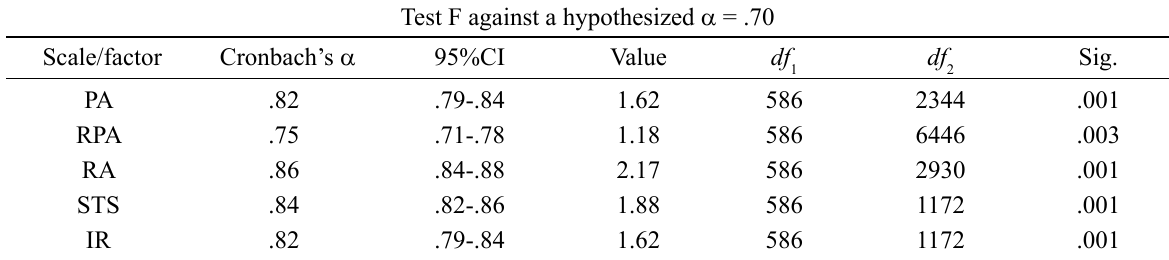
Tests for Reliability Estimate of the PARB-Q